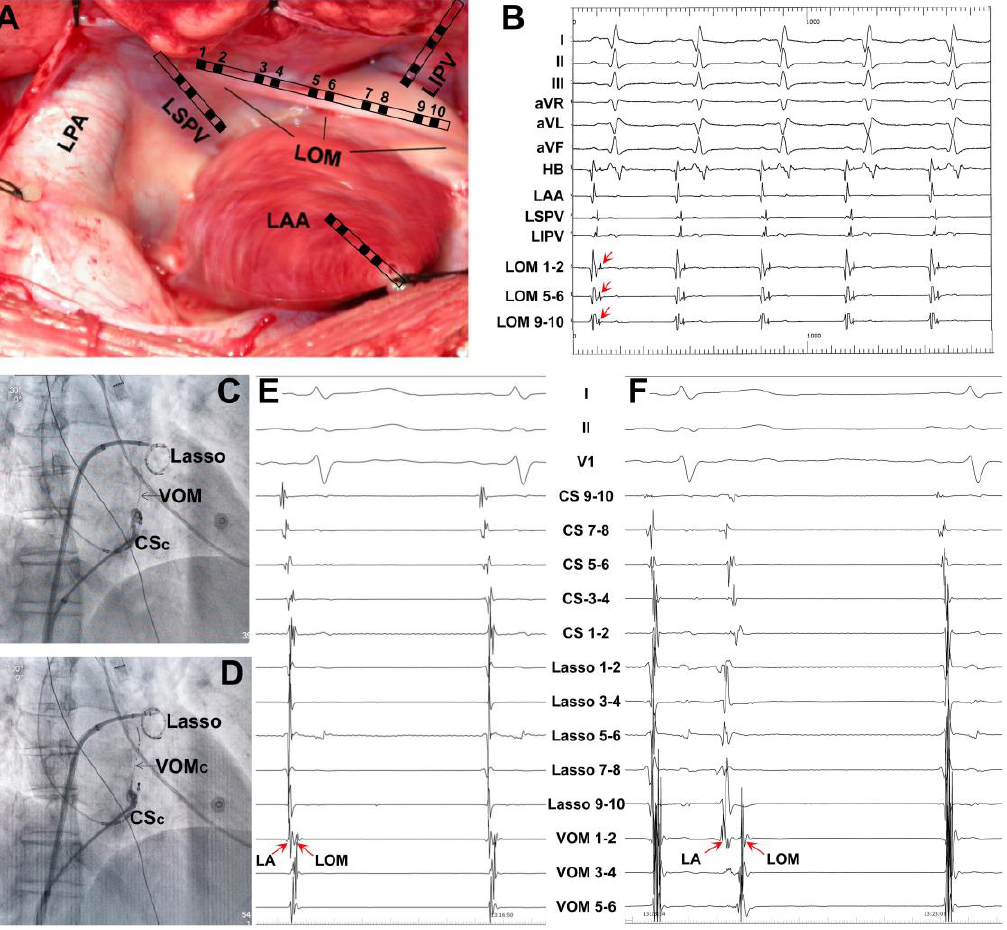
Figure 2. Recordings of the potentials of the ligament of Marshall (LOM) in dogs and humans. ( A ) The catheter position and anatomy of LOM in a dog. ( B ) Simultaneous recording of surface